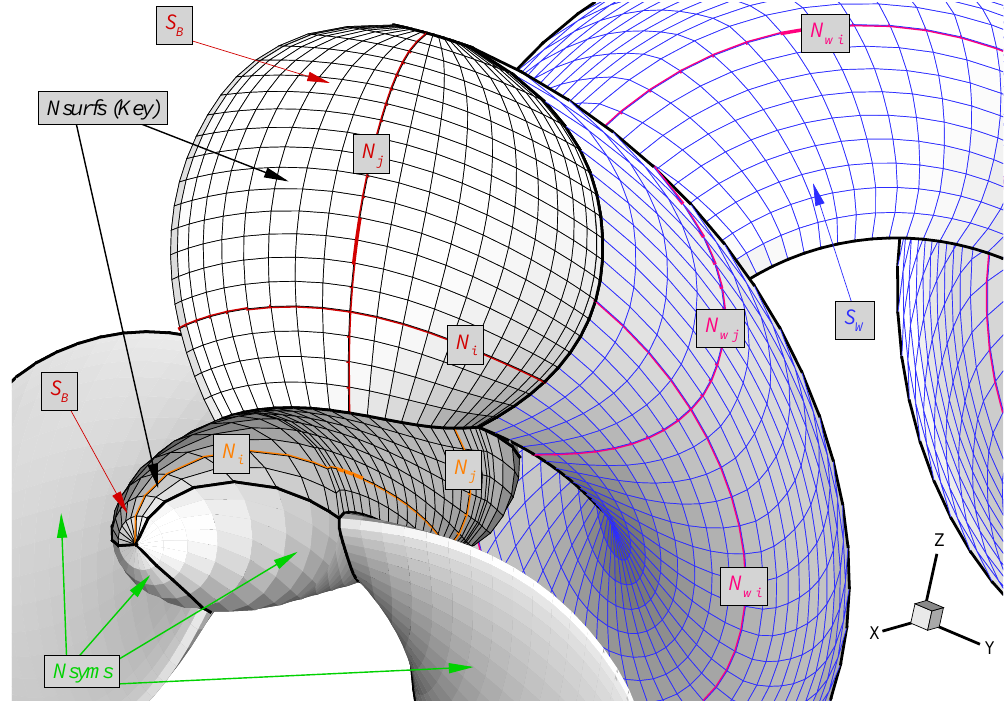
Figure 4. Geometry discretisation parameters for an unsteady propeller calculation. (Image republished from [19] with permission of the